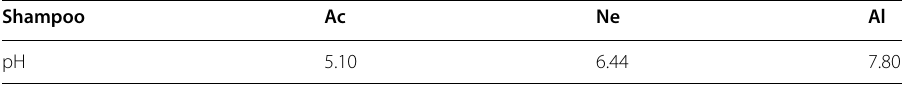
Table 4 Result of pH measurements of the three types of shampoos Shampoo Ac Ne Al pH 5.10 6.44 7.80